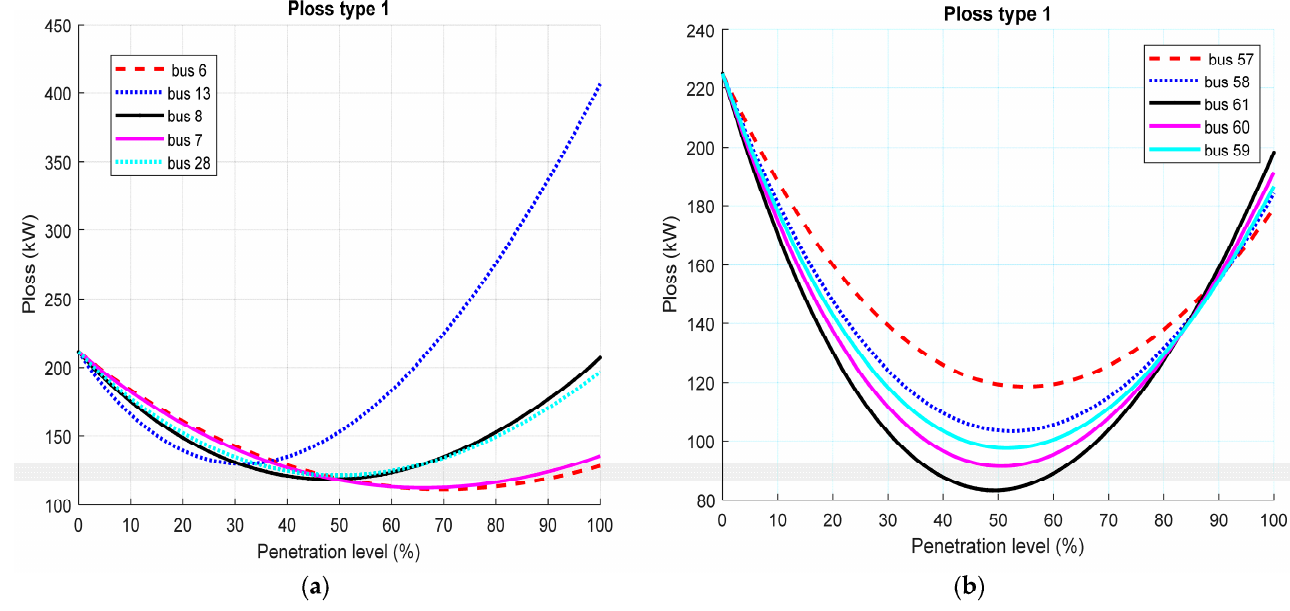
Figure 13. Real power loss when Type 1 DG was interconnected to selected nodes of ( a ) IEEE 33-bus ( b ) IEEE 69-bus.